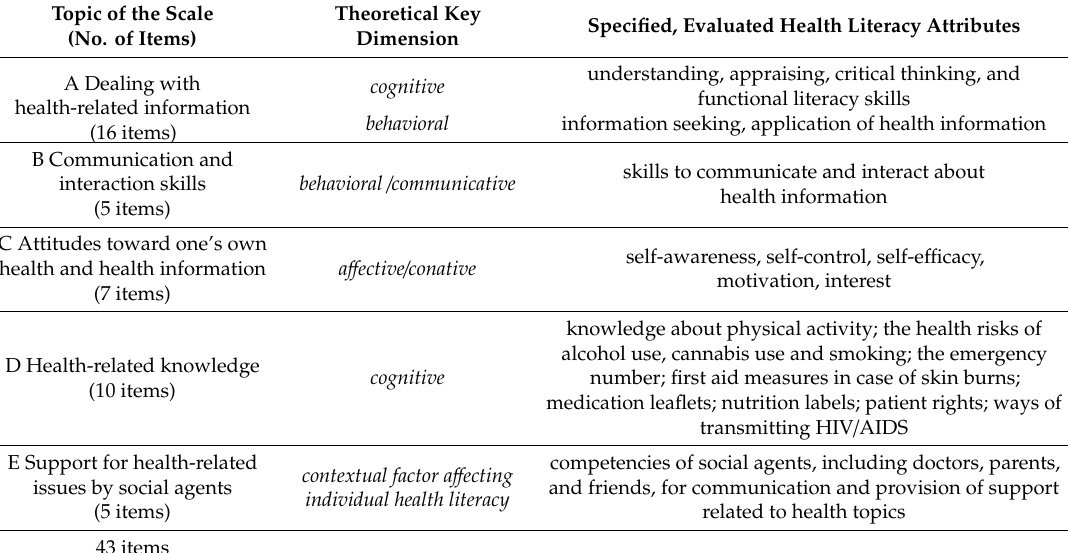
Table 1. 2nd draft of the MOHLAA-Q: Assessed topics and related skills. Topic of the Scale (No. of